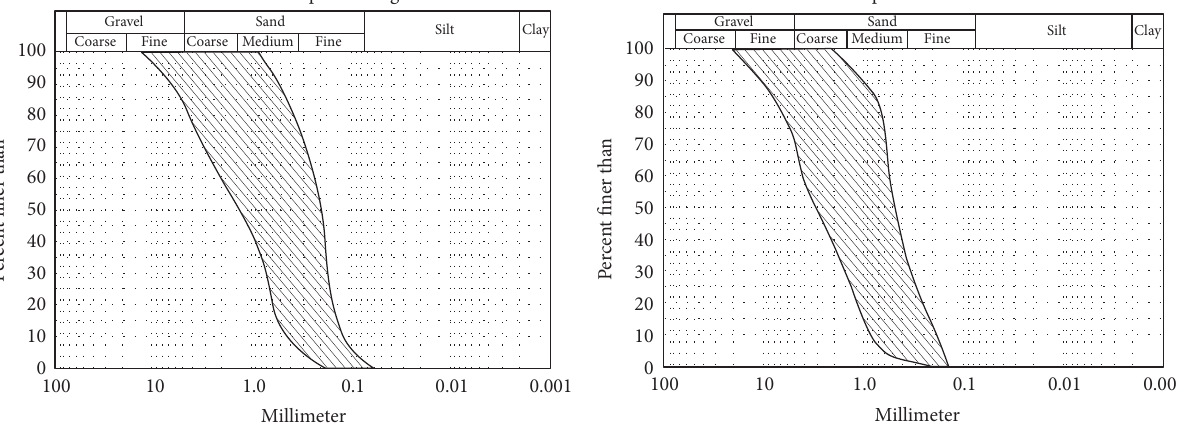
Figure 5: Grain size envelope of the existing deposits in the testing area and site of Jebba dam project